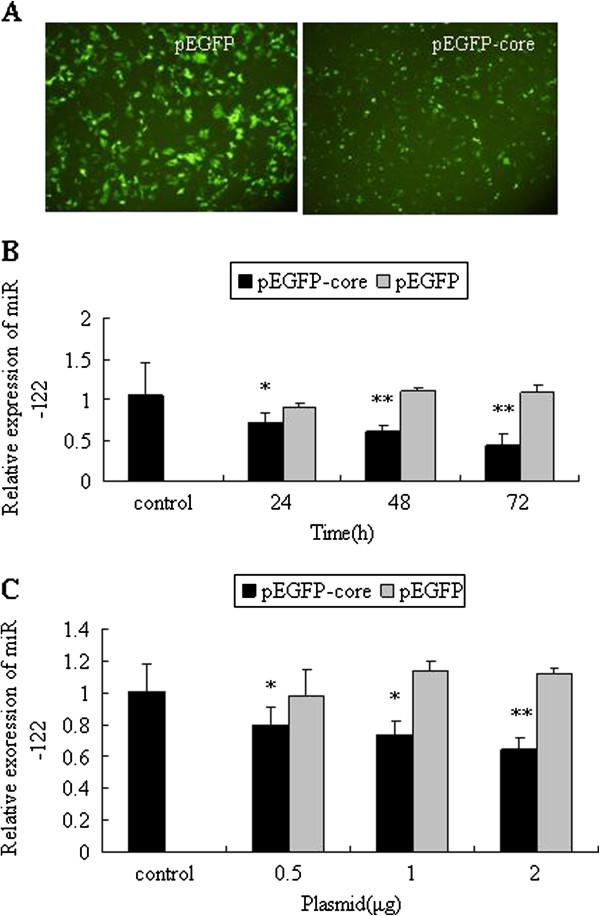
HCV core protein suppressed the expression of miR-122. (A) The intensity of EGFP in Huh7.5.1 cells transfected with plasmid pEGFP-core or pEGFP was observed by fluorescence microscopy. (B) Huh7.5.1 cells transfected with 1.5 μg of plasmid pEGFP-core or pEGFP were harvested at 24 h, 48 h and 72 h posttransfection. The relative expression of miR-122 was detected, using mock group as control group. (C) miR-122 expressions in Huh7.5.1 cells transfected with 0.5 μg, 1 μg and 2 μg of the plasmid pEGFP-core or pEGFP were detected at 48 h posttransfection, using mock group as control group. The data were presented as means ± SD of three independent experiments. *P < 0.05, **P < 0.01 vs. control group.